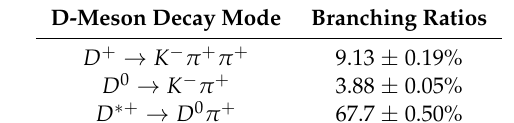
Table 1. D-mesons decay mode and their branching ratios [10].